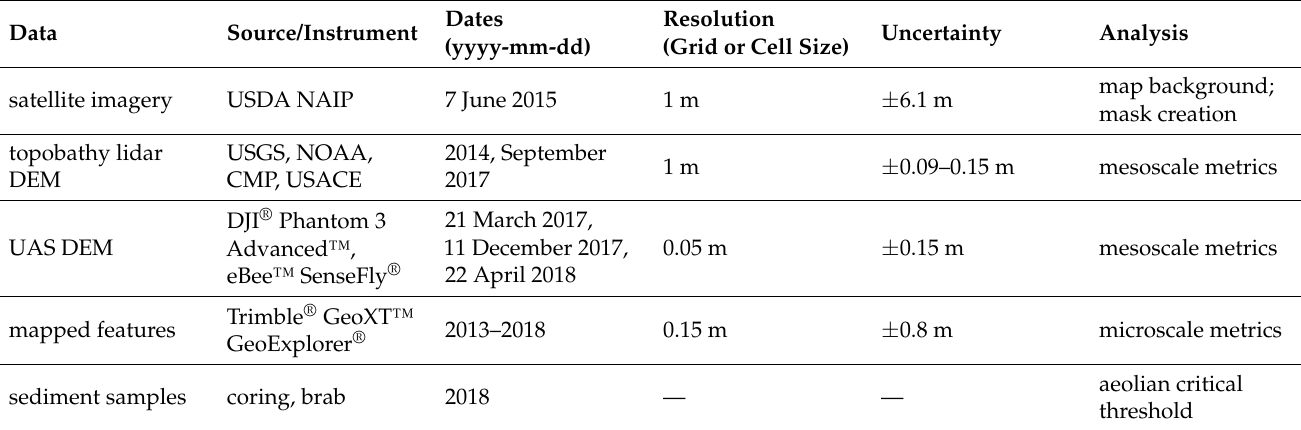
Table 2. Remotely sensed data sources, platforms, dates, spatial resolutions, and uncertainties.